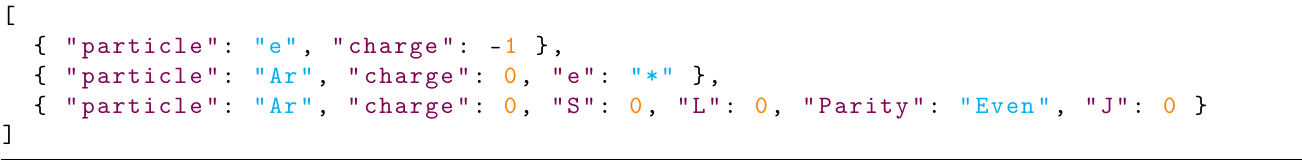
Figure 13. Using a collection of documents instead of a table is a lot more suited to heterogeneous data. Meanwhile, object structure can be controlled by defining a JSON Schema document that all entries should adhere